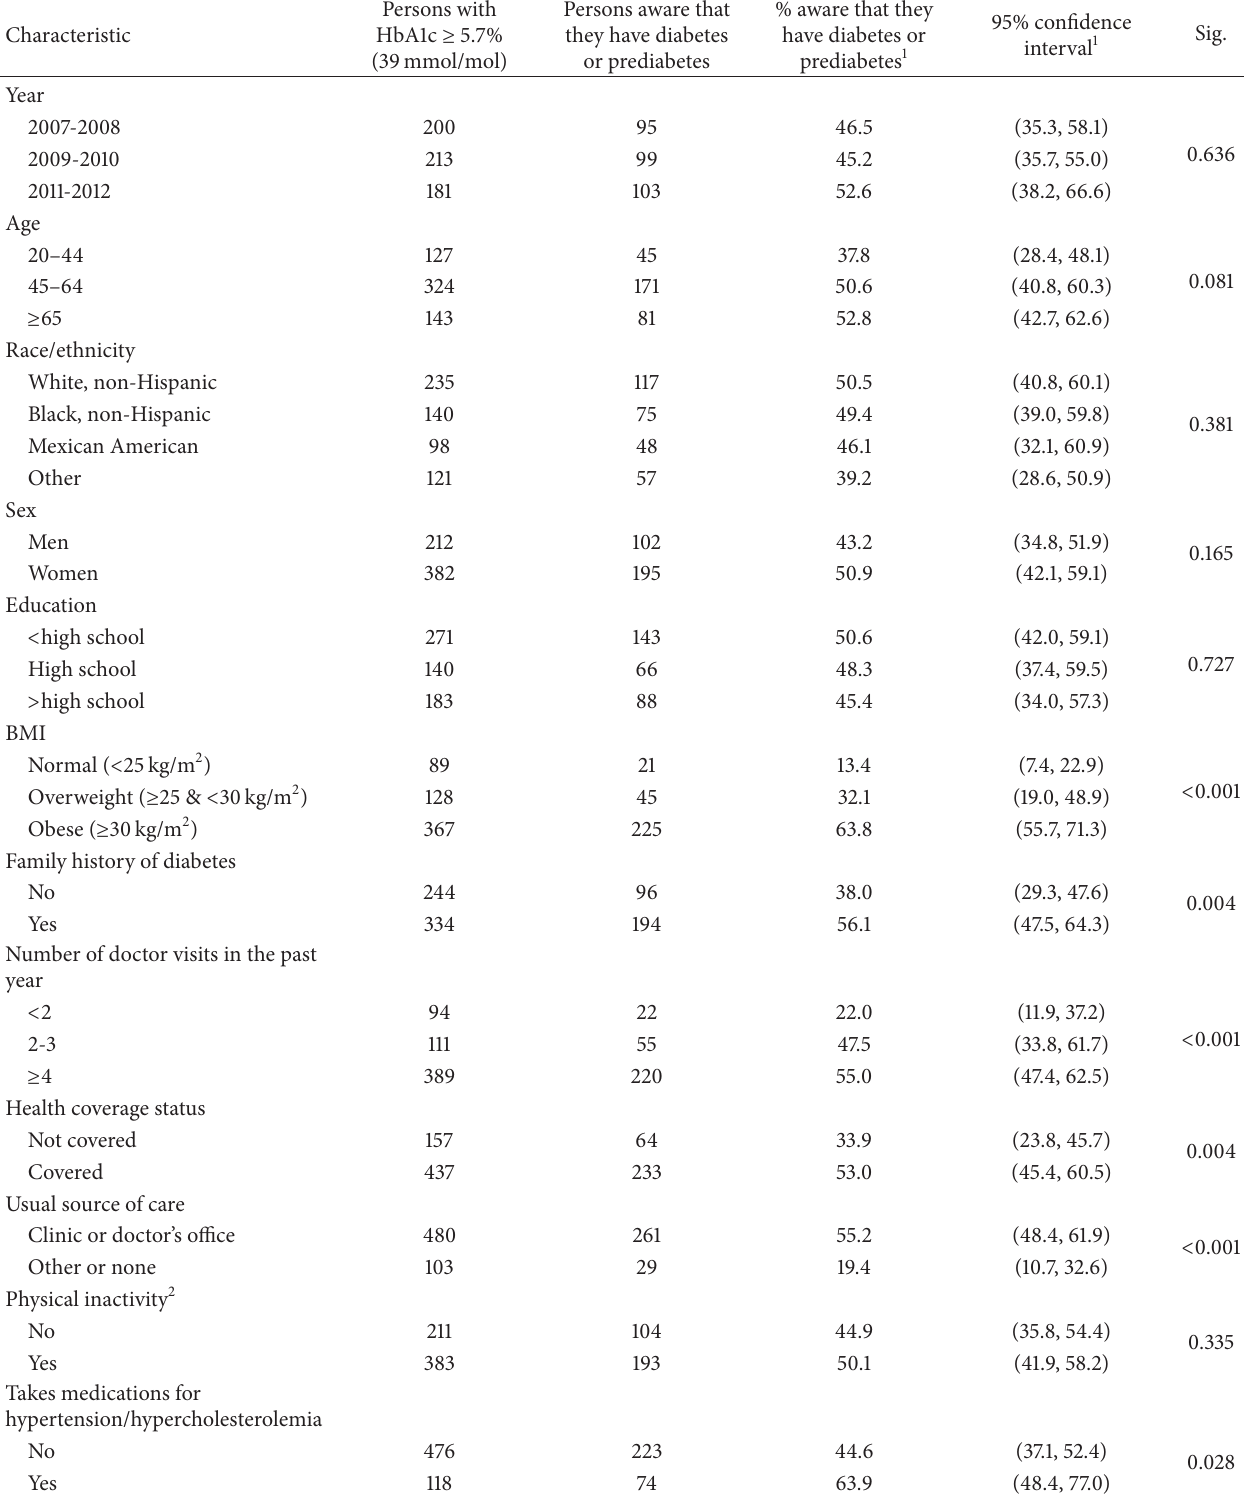
Table 3: Prevalence of awareness of having HbA1c values in the prediabetes/diabetes ranges in nonpregnant persons ≥ 20 years of age with clinical depression and elevated HbA1c (in